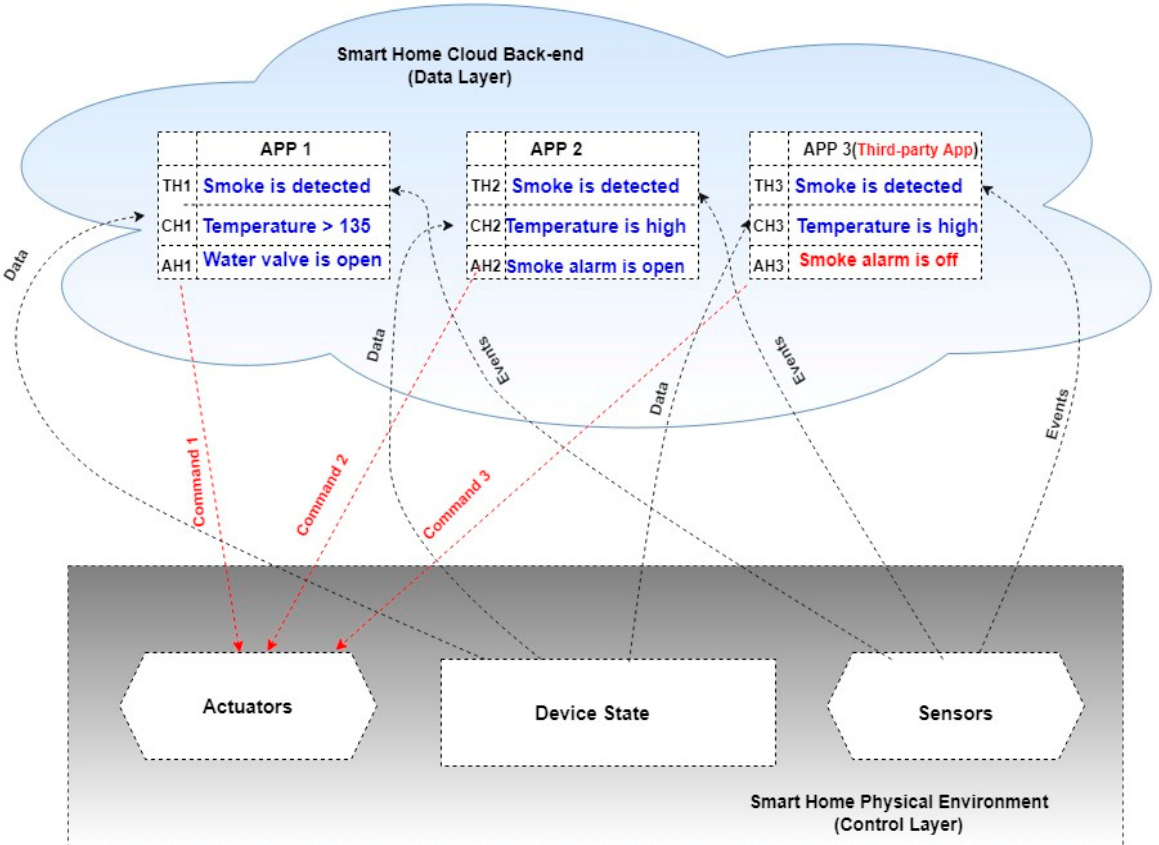
Figure 4. Smart home apps, including malicious third-Party apps.